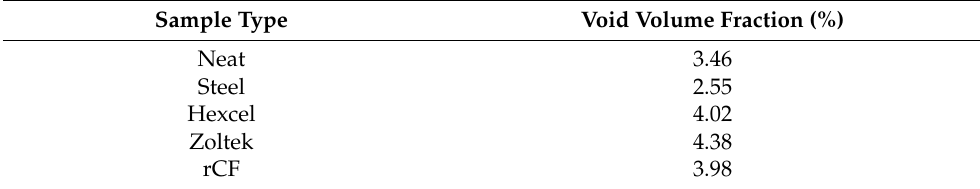
Figure 10. 2D reconstructed cross-sections of the ( A ) Zoltek carbon fiber and ( B ) rCF reinforced concrete mix design showing detected fiber bundles’ microstructural features using µ -XCT technique. Table 5. Void volume fraction of concrete mix designs.